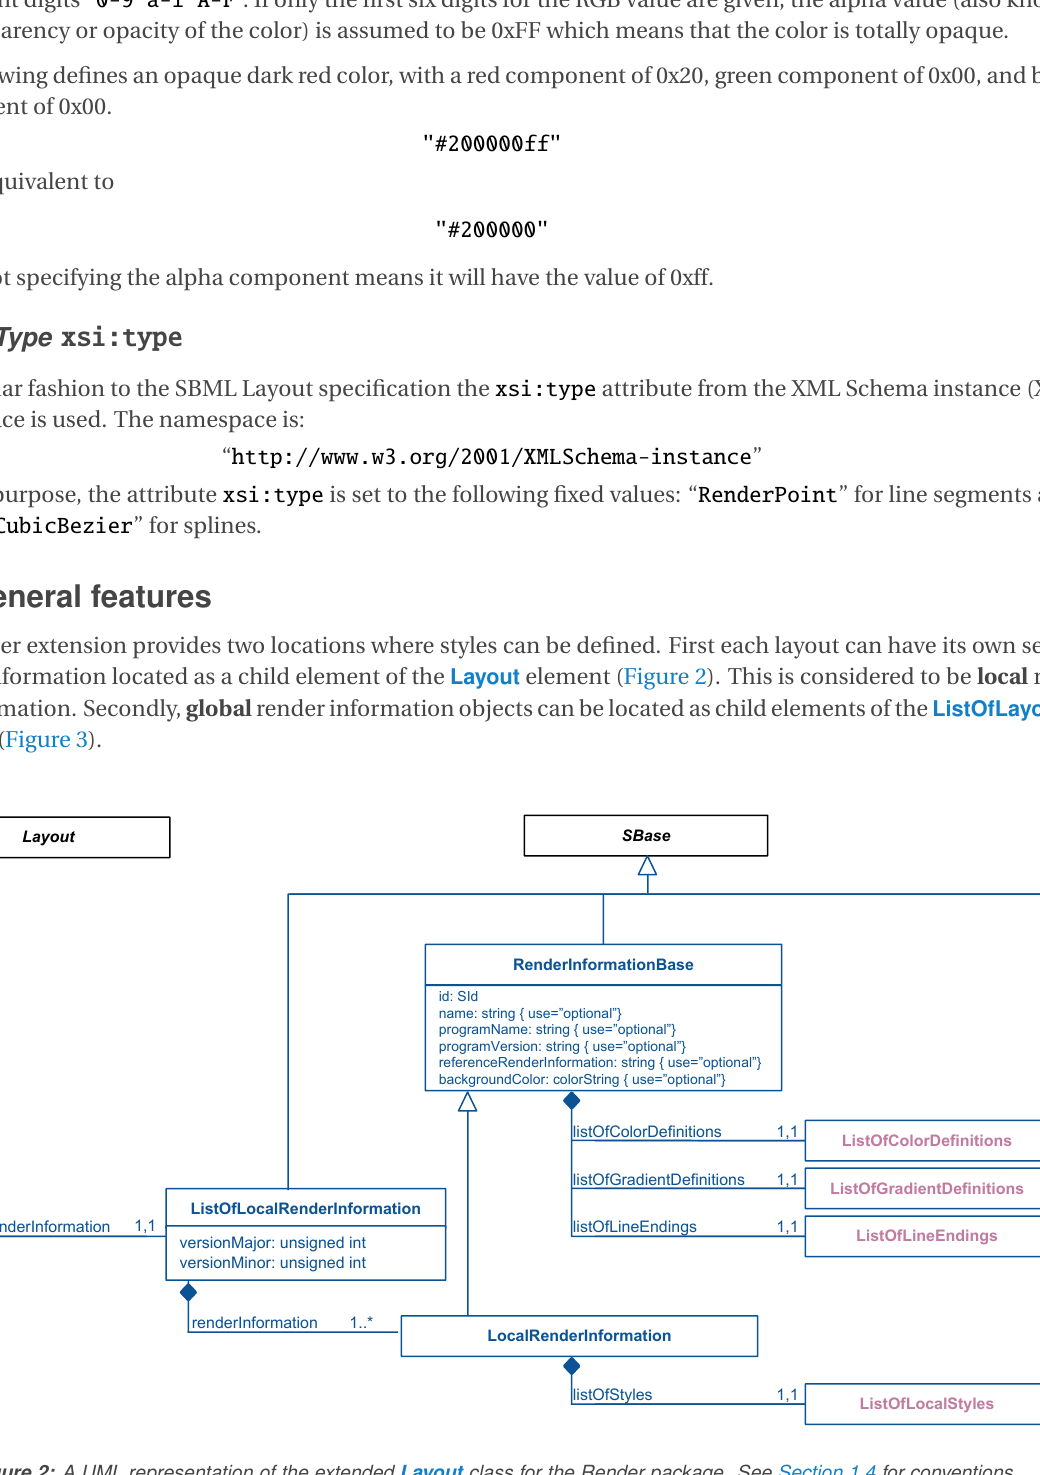
Figure 2: A UML representation of the extended Layout class for the Render package. See Section 1.4 for conventions related to this